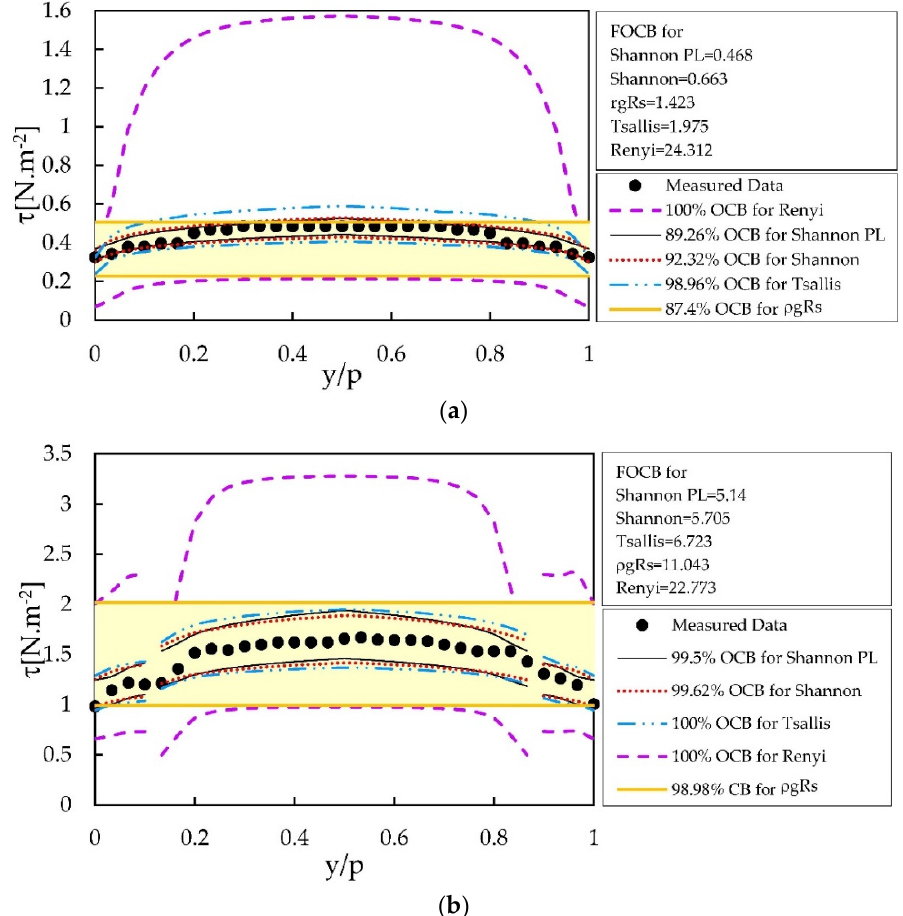
Figure 7. OCB for analyzing presented models in shear stress prediction by HBMES-2 uncertainty method in height ratios ( a ) t / D = 0, h + t / D = 0.333; and ( b ) t / D = 0.25; h + t / D = 0.333).